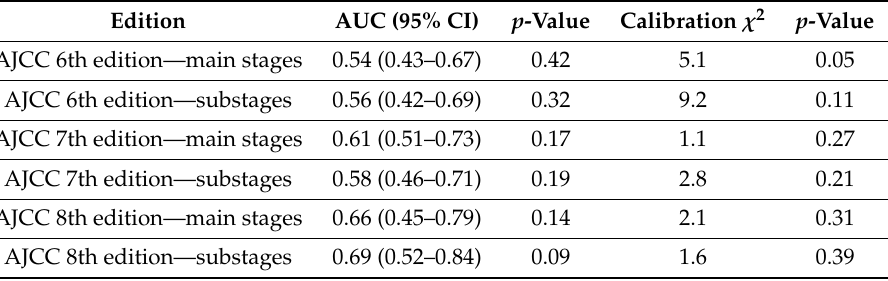
Table 7. Discrimination power and calibration of the 6th, 7th, and 8th editions of the American Joint Committee on Cancer (AJCC) staging system. AUC: area under the